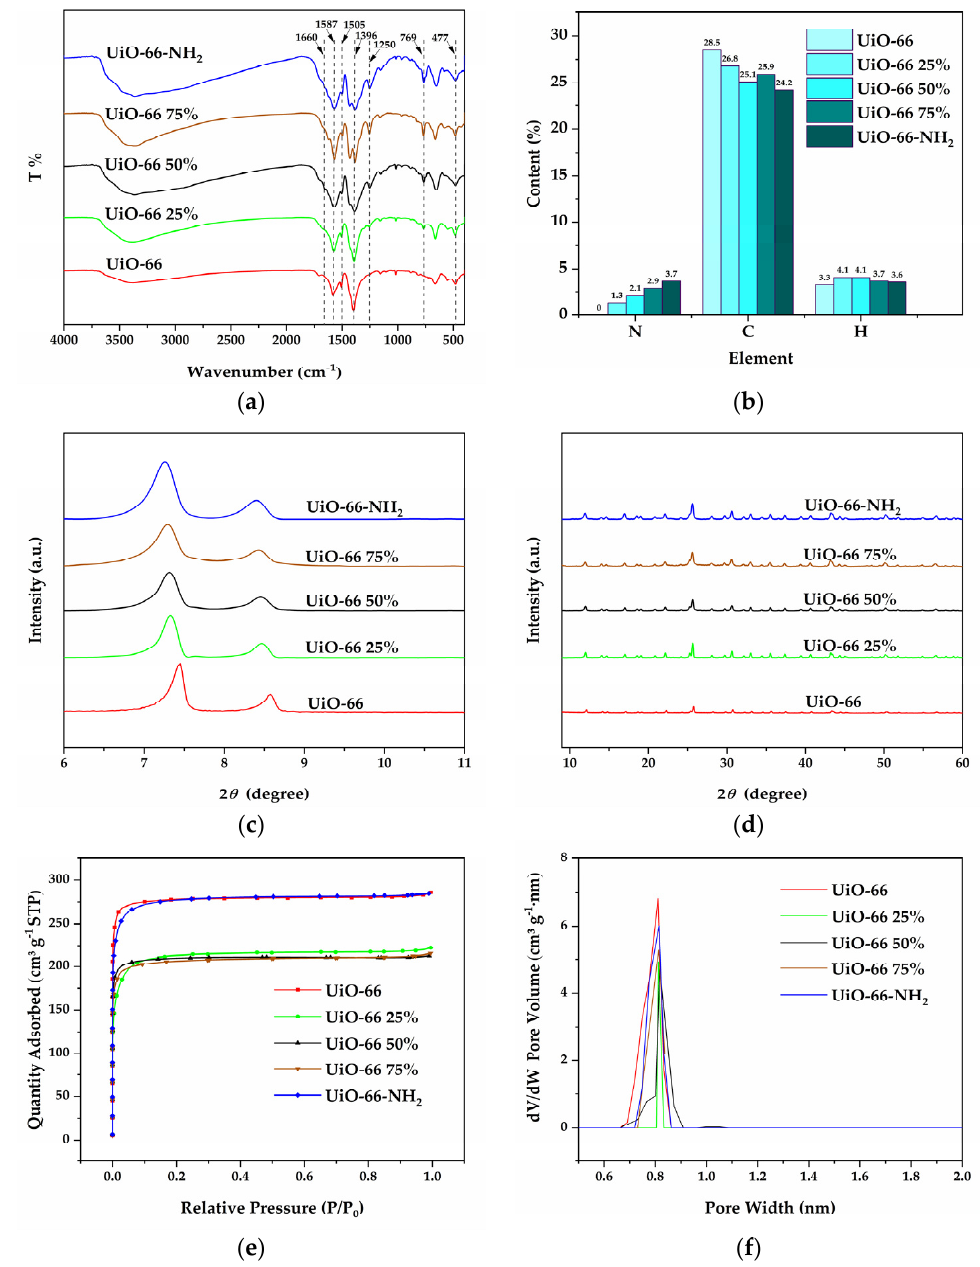
Figure 3. FTIR spectrum ( a ) and elemental contents ( b ) and XRD pattern ( c , d ) and N 2 adsorption–desorption isotherms curves ( e ) and pore size distributions ( f ) of UiO-66 X%.